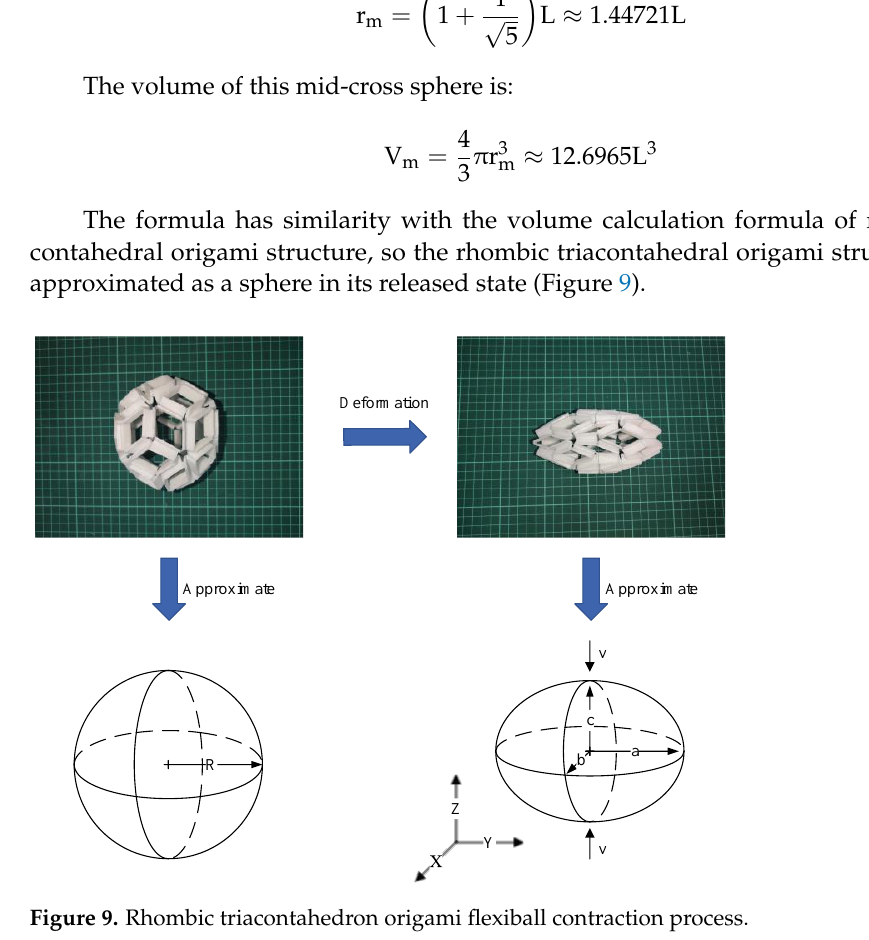
Figure 9. Rhombic triacontahedron origami flexiball contraction process.